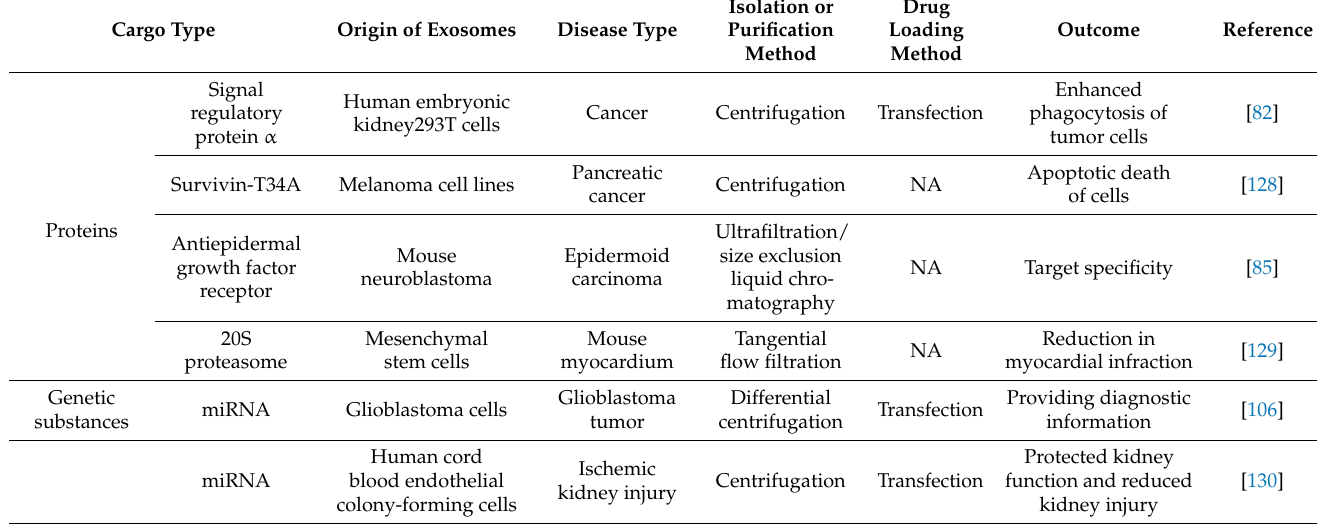
Table 2. Examples of exosomes as drug delivery